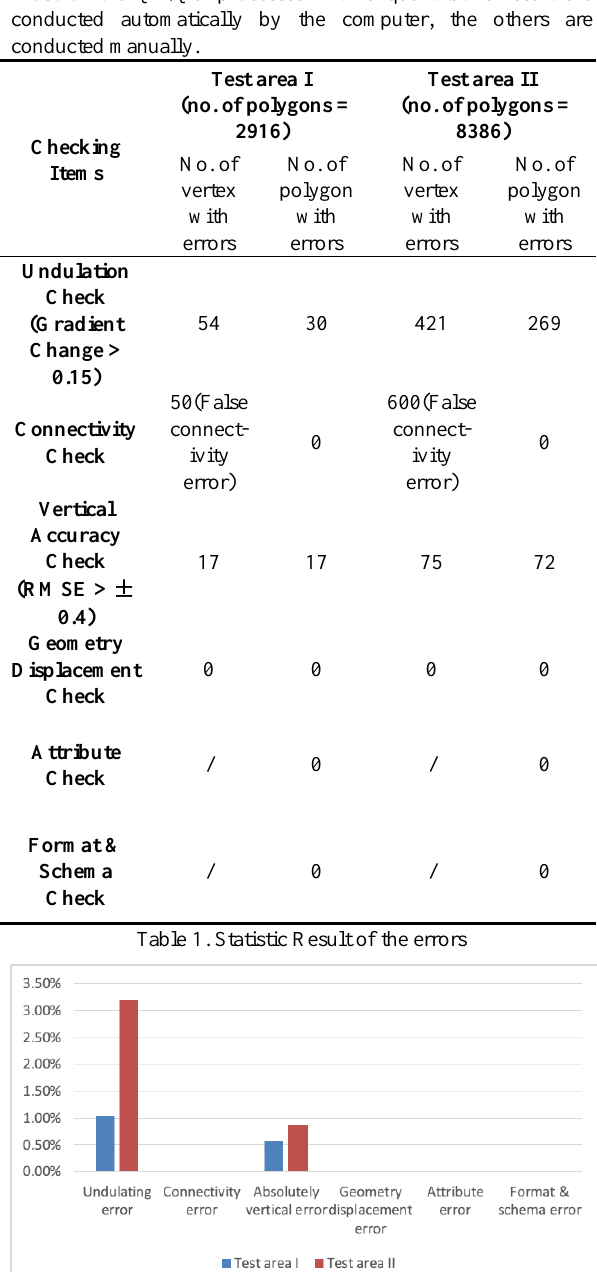
Figure 4. Statistic error of each quality element. The blue color is for the Test area I, and the red color is for the Test area